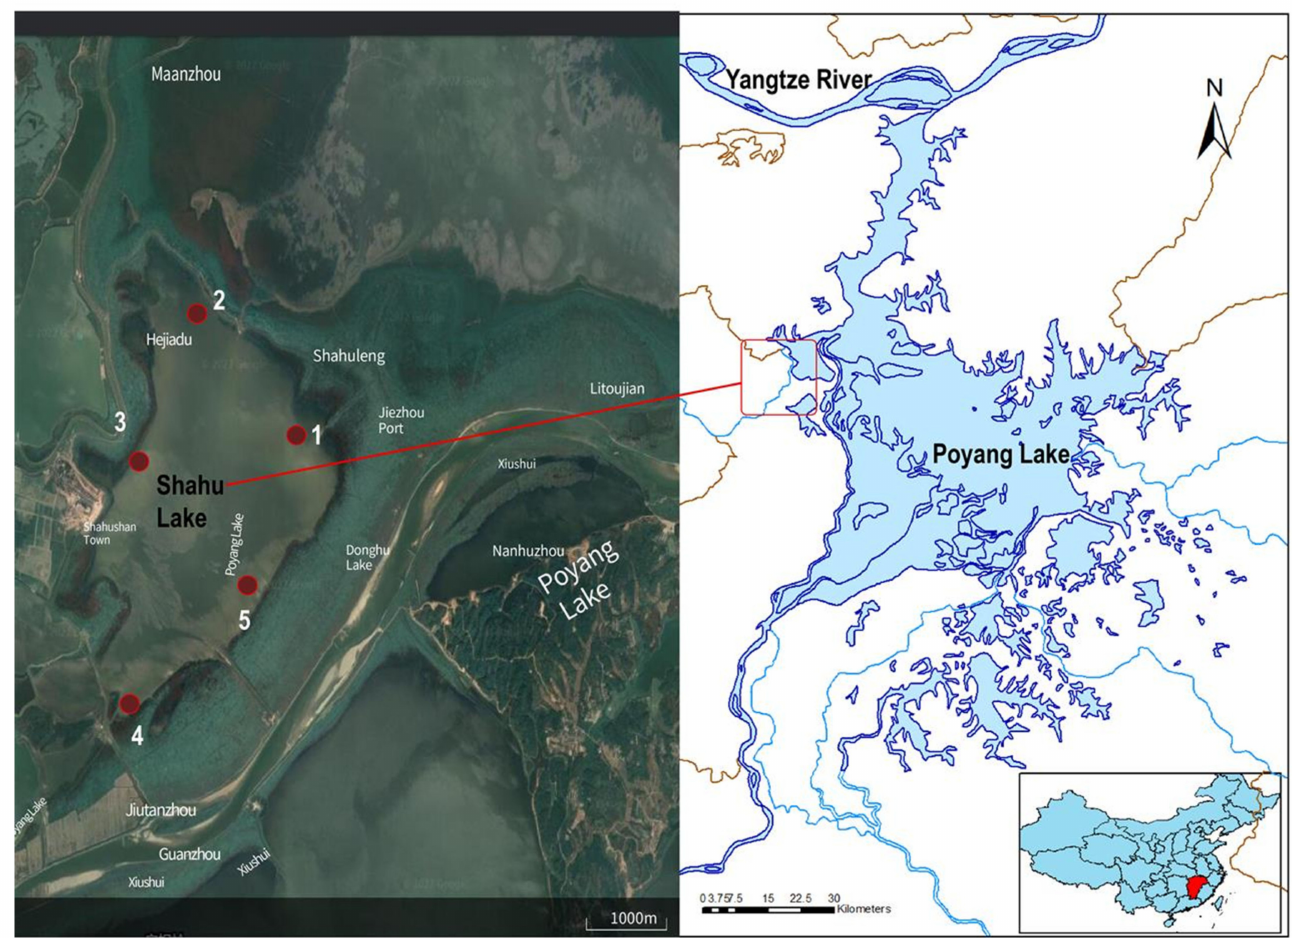
Figure 1. Sites sampled in the sub-lake Shahu Lake of the floodplain–wetland complex of Poyang Lake (Northern Jiangxi Province, China). The sampling sites are numbered 1, 2, 3, 4, and